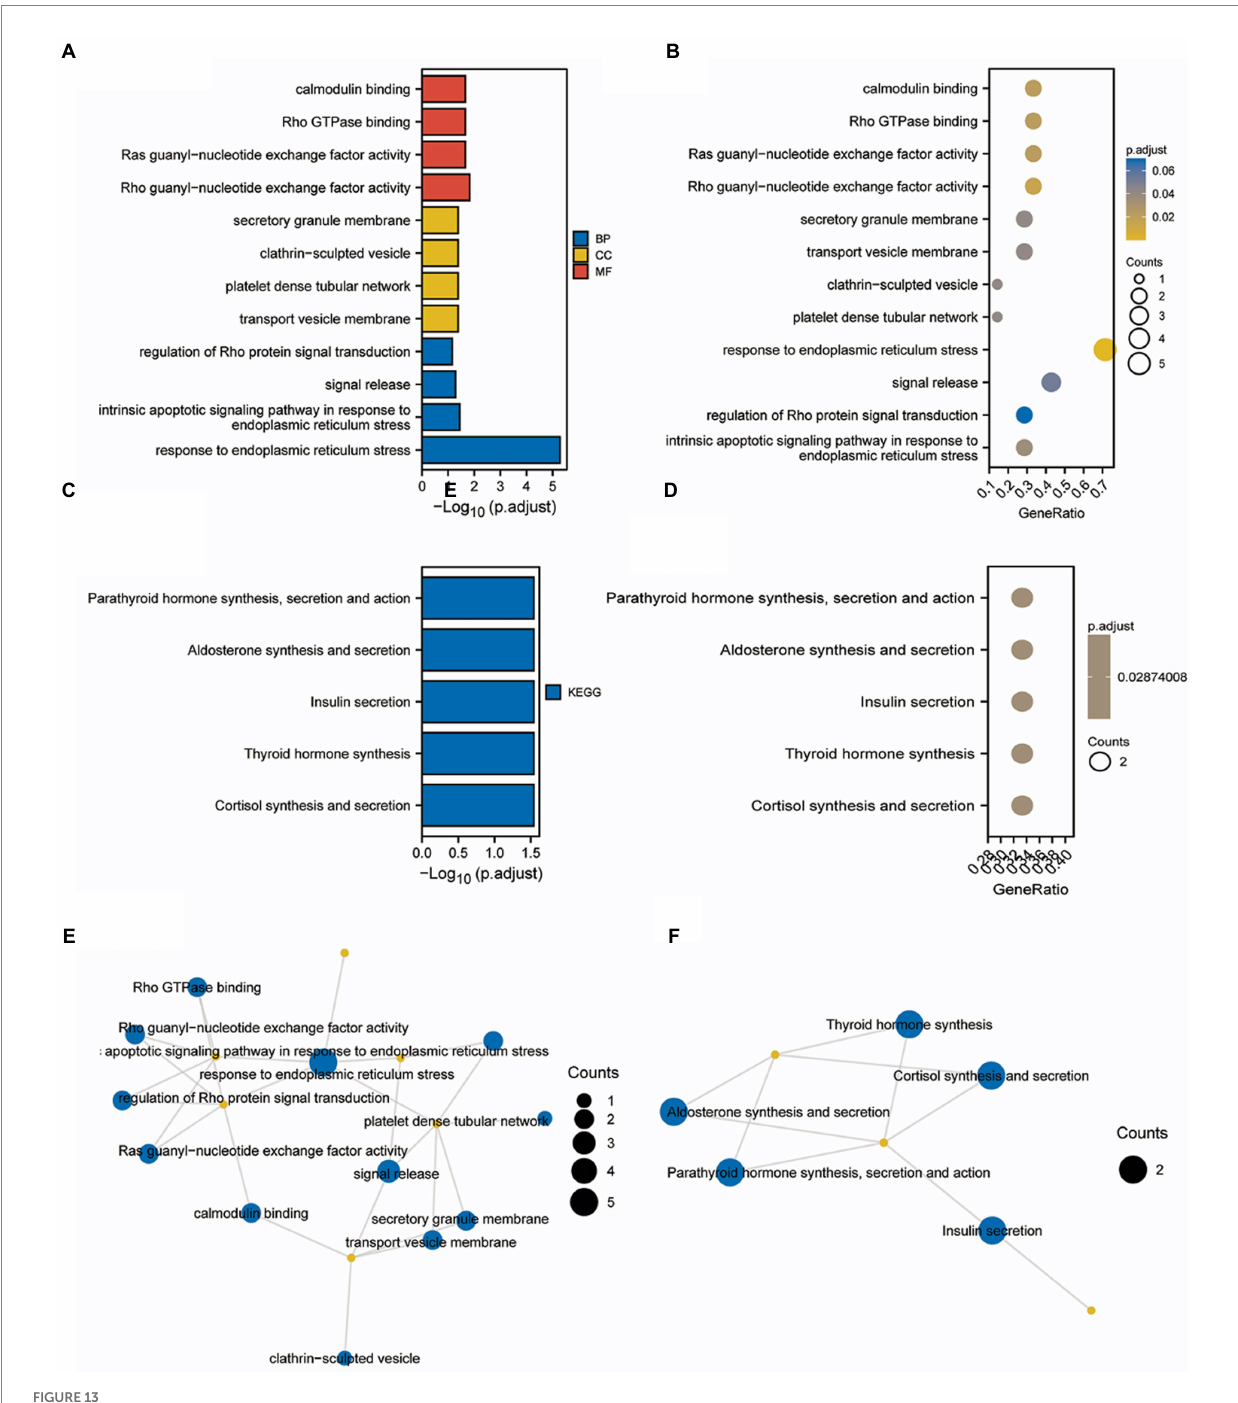
FIGURE 13 GO/KEGG enrichment analysis of Hub genes related to TMEM131L oxidative stress. (A) The length of the column in the GO enrichment analysis bar graph shows the number of enriched genes; (B) Analysis of GO enrichment using a bubble map, the significance gradually climbed from yellow to blue while the size of the bubbles reflected the degree of gene enrichment; (C) The length of the column in the KEGG enrichment analysis bar graph shows the number of enriched genes; (D) According to the bubble map produced by the KEGG enrichment analysis, the size of the bubbles corresponded to the degree of gene enrichment, and the color indicated the significance, which steadily grew from yellow to blue. (E,F) Enrichment Term of GO and KEGG enrichment